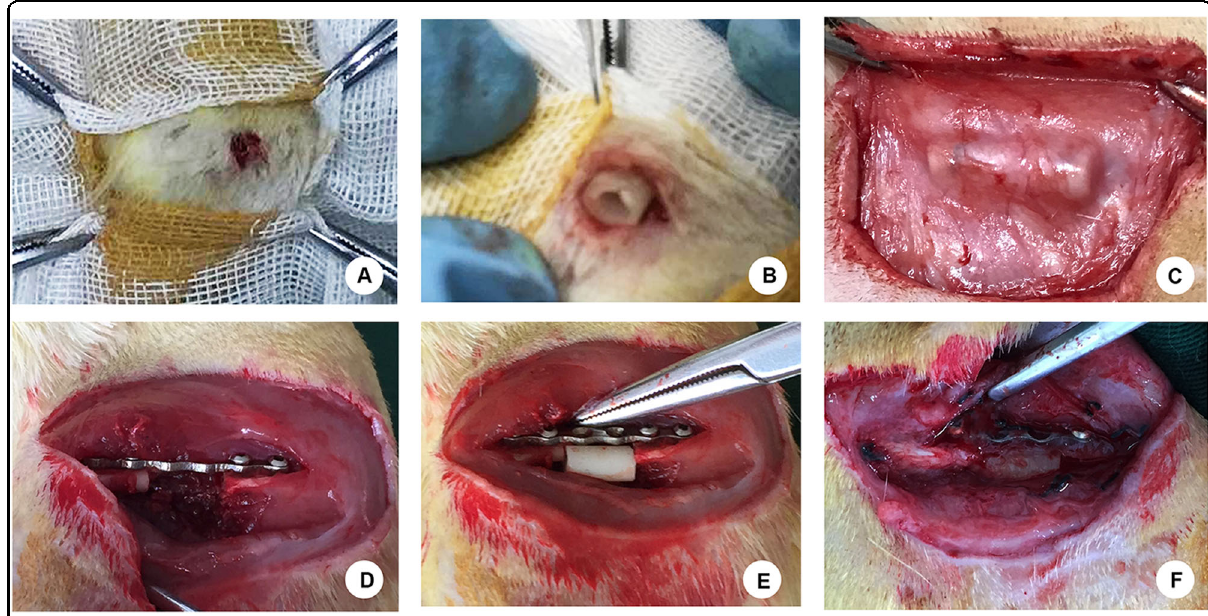
Fig. 1 Surgical procedure for the Masquelet ’ s induced membrane model in both the subcutaneous site and femoral defect site. a A 5-mm incision was created on the left thigh to create a 10-mm pocket. b The PMMA cylinder was inserted into the pocket. c The induced membrane formed in the subcutaneous region was exposed at 6 weeks after surgery. d A 10-mm critical-size femoral defect was created in the right femur, which has been previously fi xed with a 6-well titanium mini-plate. e The PMMA spacer was inserted into the femoral defect area. f The induced membrane formed in the femoral defect site was exposed after 6 weeks of